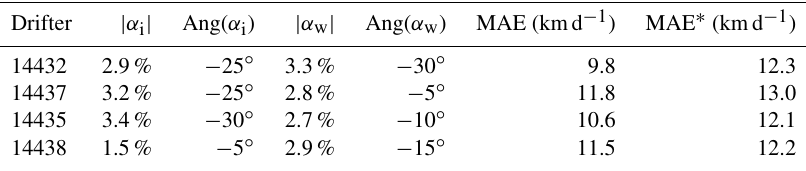
Table 2. Best fit for leeway coefficients using the TOPAZ forcing. MAE ∗ is the mean absolute error using leeway values of α i = 0 . 02 e − iπ/ 6 and α w = 0 . 03. Negative angles imply clockwise direction relative to